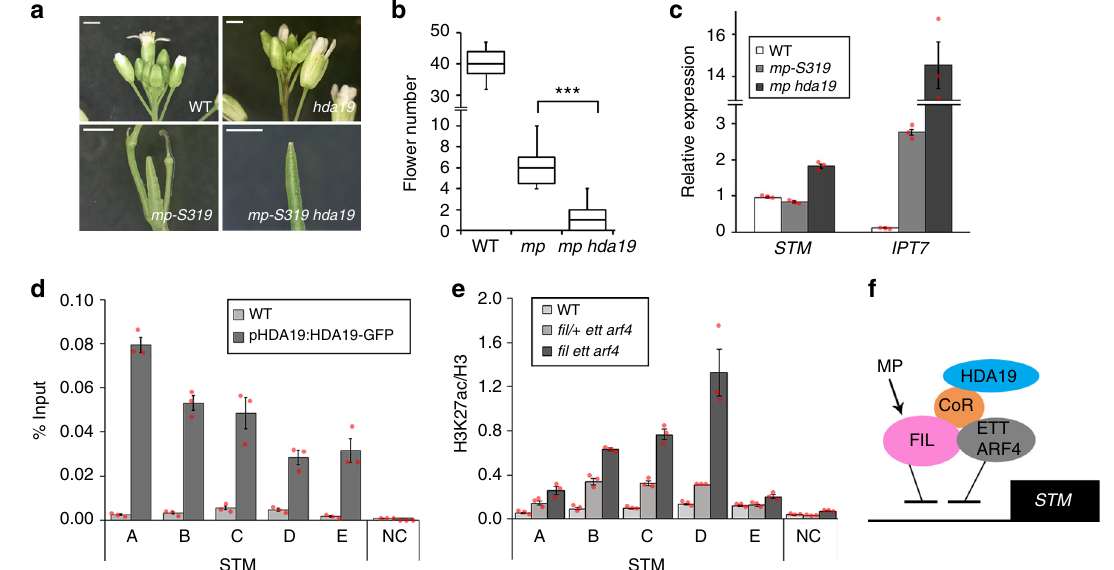
Fig. 7 STM repression by FIL and ETT/ARF4 relies on reduced histone H3 acetylation. a , b Flower initiation phenotypes of wild type (WT), hda19 , the hypomorph mp-S319 mutant and mp-S319 hda19 . a Phenotype; Scale bar = 1 mm. b Quanti fi cation of fl owers formed; *** P = 0.00024,